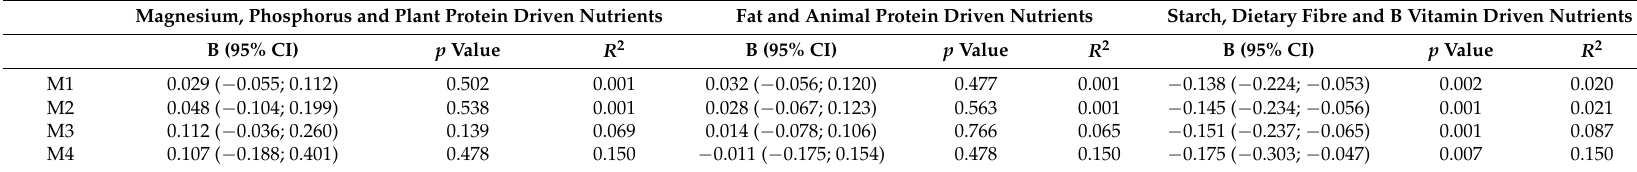
Table 4. Regression coefficients for glycated haemoglobin for 1 SD increase in the derived nutrient pattern scores among rural black South African women. Magnesium, Phosphorus and Plant Protein Driven Nutrients Fat and Animal Protein Driven Nutrients Starch, Dietary Fibre and B Vitamin Driven